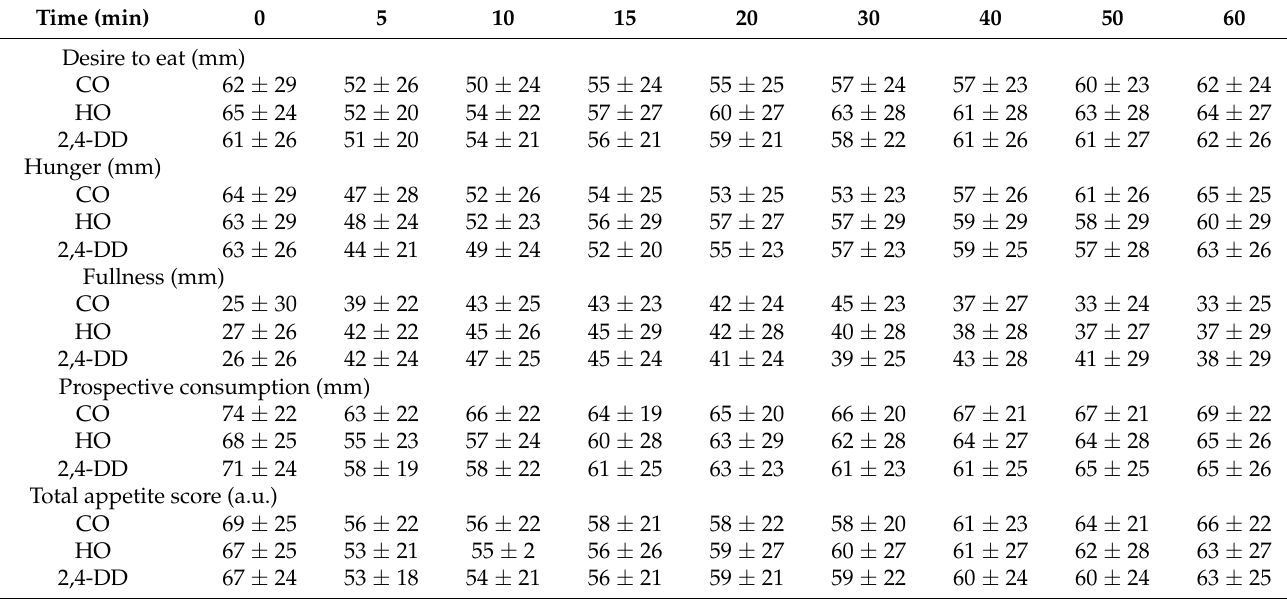
Table 2. Participants’ appetite scores (mean values and standard deviations) in Experiment